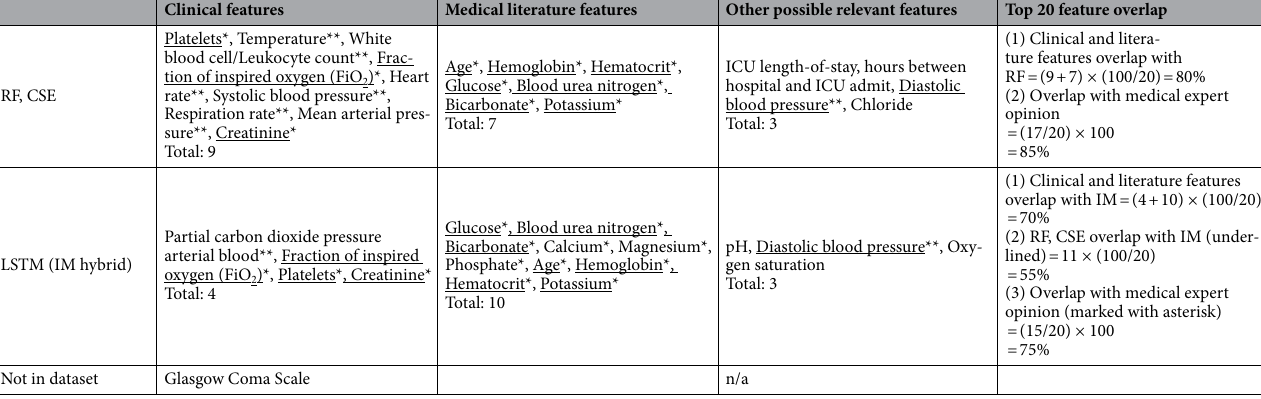
Table 1. This table summarizes our results and shows the breakdown of the top 20 (out of 40) features found by the CSE to be relevant for sepsis detection. These 20 features are then used to compare the features found by the IM with (i) clinical features, (ii) features from literature, and (iii) features from human medical experts (marked with single and double asterisks). Note, a single asterisk means that the feature is chosen by at least one of our medical expert; while double asterisks mean that the feature is chosen by both medical experts. The table also shows relevant features that the CSE and LSTM used for the sepsis classification task, but currently not regarded as important in the sepsis medical community. The overlap between the CSE and IM is also displayed